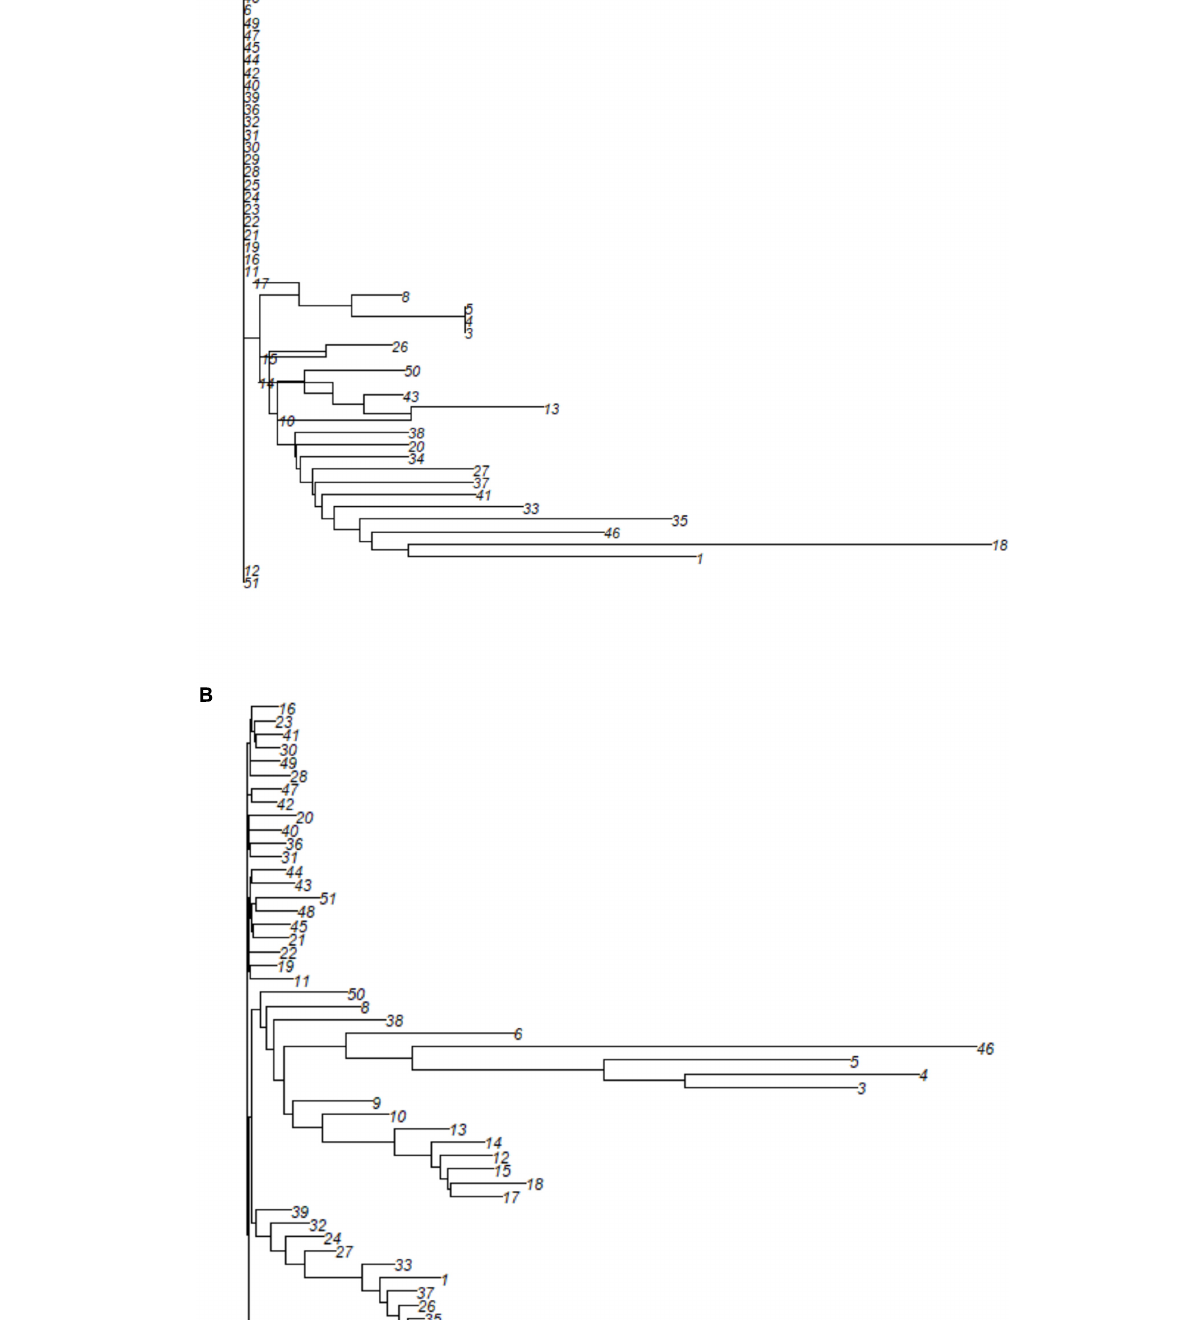
site 1 and one young individual from site 2, and Cluster 5 is a mixture of middle-age palms from sites 1 and 2 and most young palms from site 2. All individuals in Cluster 5 (at the